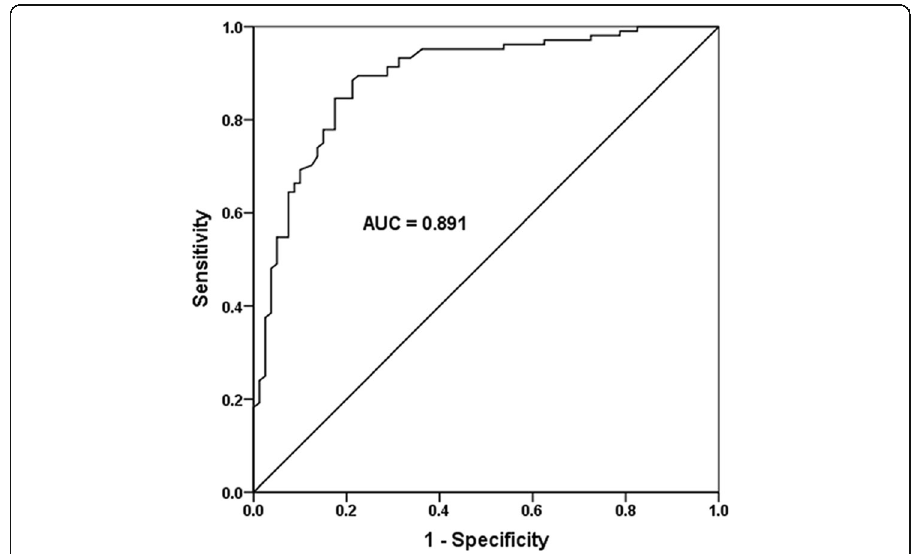
Fig. 3 An ROC curve was established to assess the discriminative ability of serum miR-186-5p for identifying atherosclerosis patients from control subjects. A high diagnostic power of miR-186-5p as a biomarker for atherosclerosis was detected (AUC score =